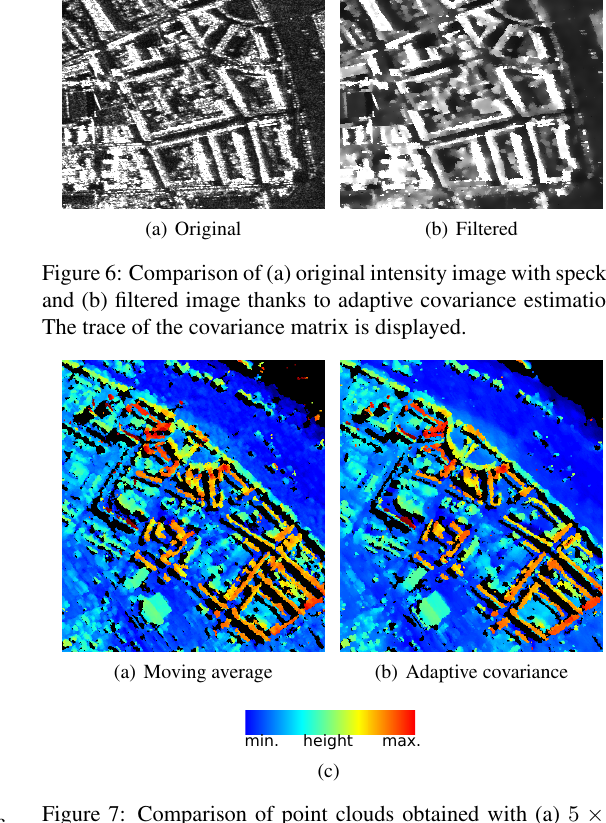
Figure 7: Comparison of point clouds obtained with (a) 5 boxcar and (b) adaptive covariance filtering. (c) Color coding of heights in this